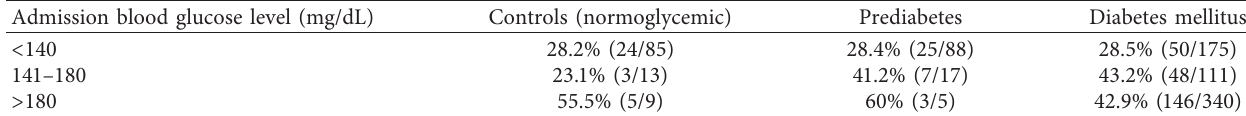
Table 8: Mortality according to admission blood glucose